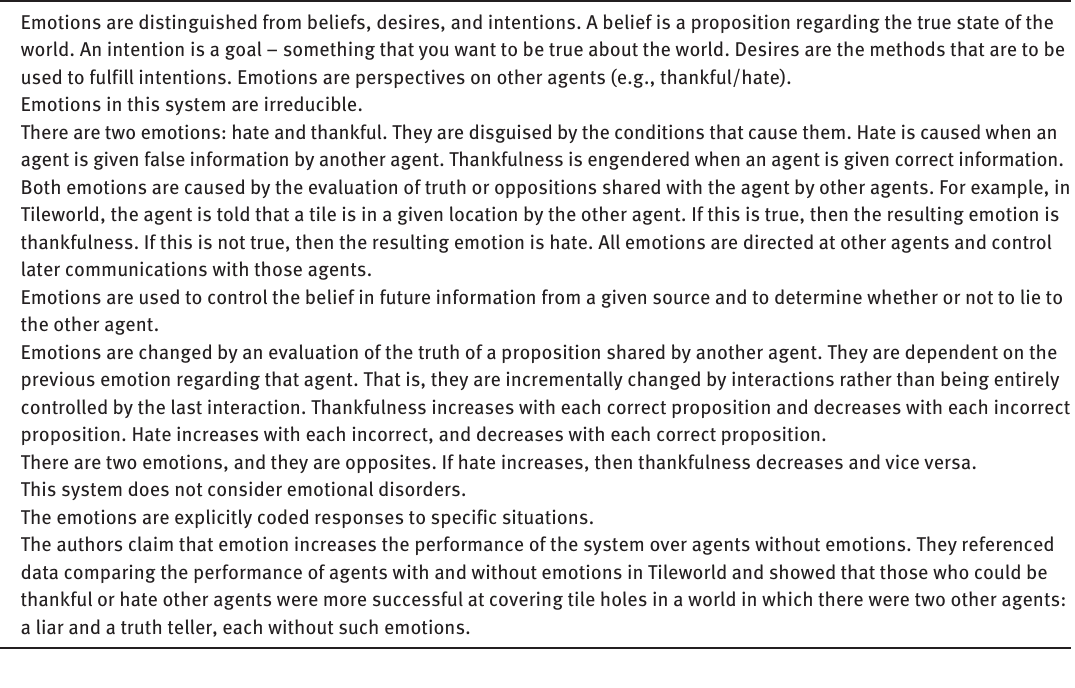
Table 14. Classification of EBDI [12].